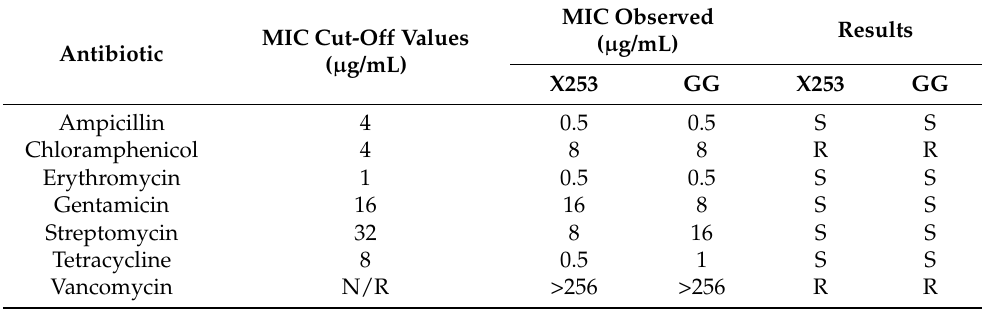
Table 3. MIC values observed for L. rhamnosus X253 and GG against several antibiotics. MIC Observed Results MIC Cut-Off Values ( µ g/mL) Antibiotic ( µ g/mL) X253 GG X253 GG Ampicillin 4 0.5 0.5 S S Chloramphenicol 4 8 8 R R Erythromycin 1 0.5 0.5 S S Gentamicin 16 16 8 S S Streptomycin 32 8 Tetracycline 0.5 Vancomycin N/R